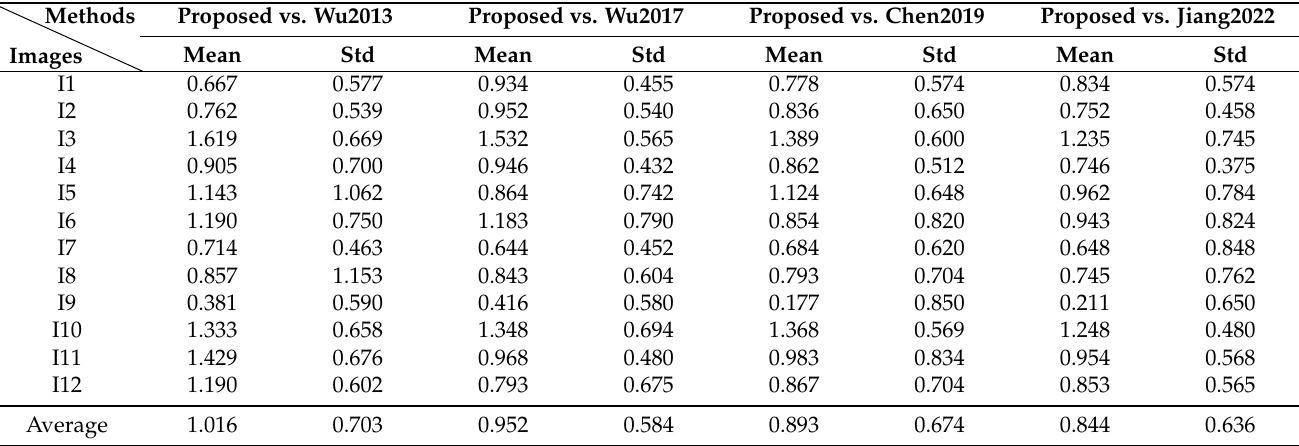
Table 4. Comparison results of subjective